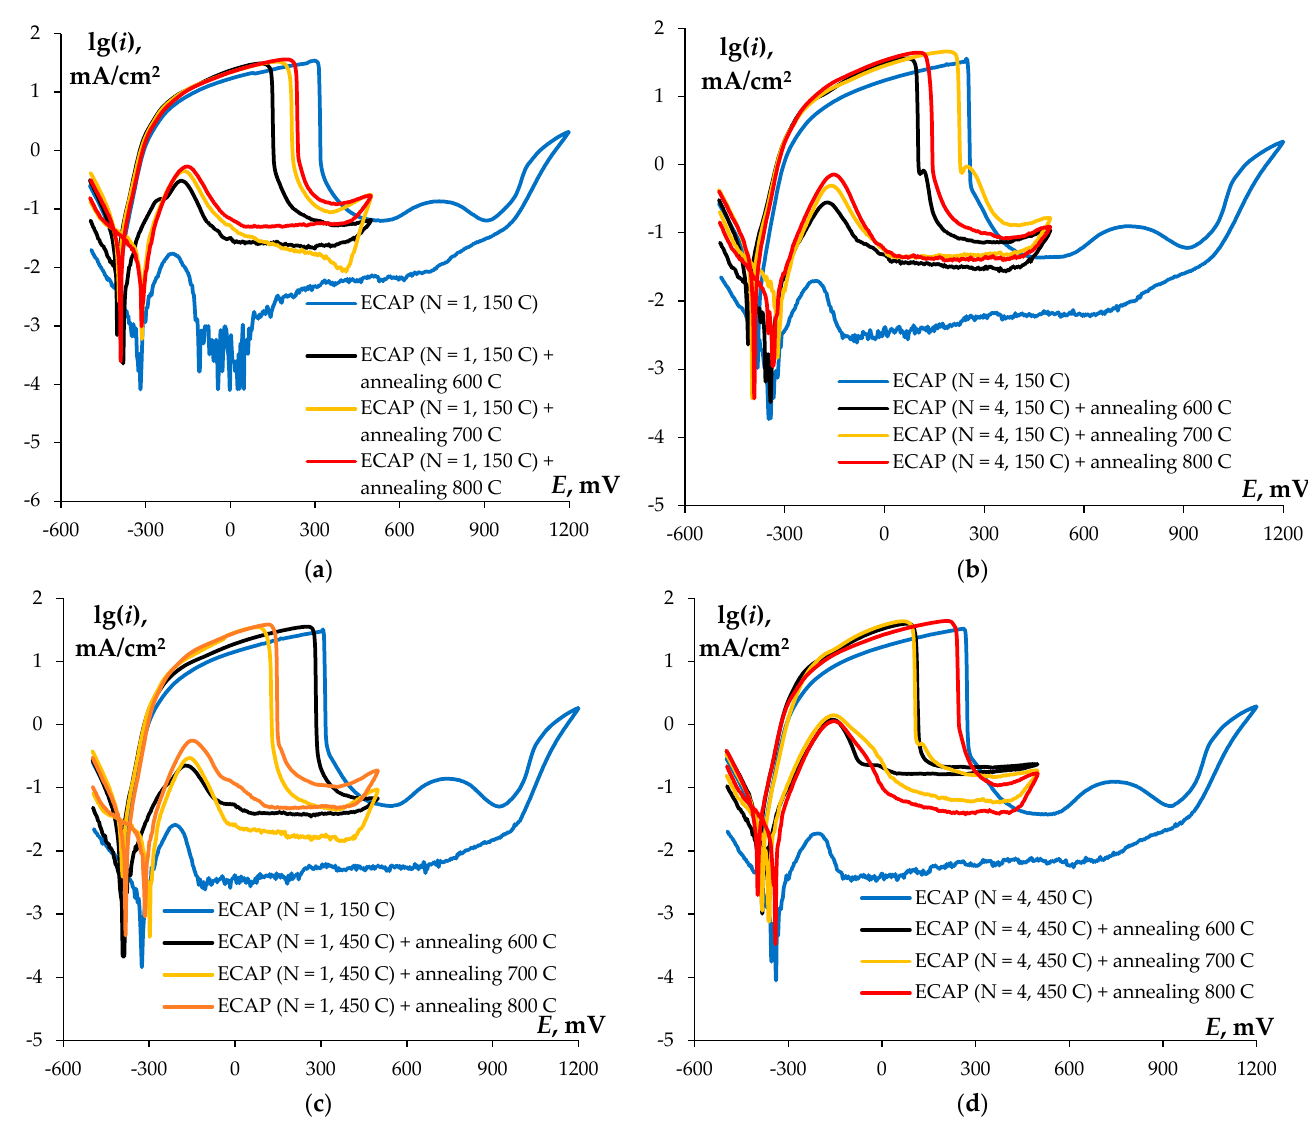
Figure 15. The effect of annealing temperature on IGC resistance in UFG steel. The results of investigations of resistance against IGC by DLEPR: lg( i )– E curves for UFG steel after ECAP at 150 °C ( a , b ), 450 °C ( c , d ) and annealing at 600, 700, 800 °C, 1 h.